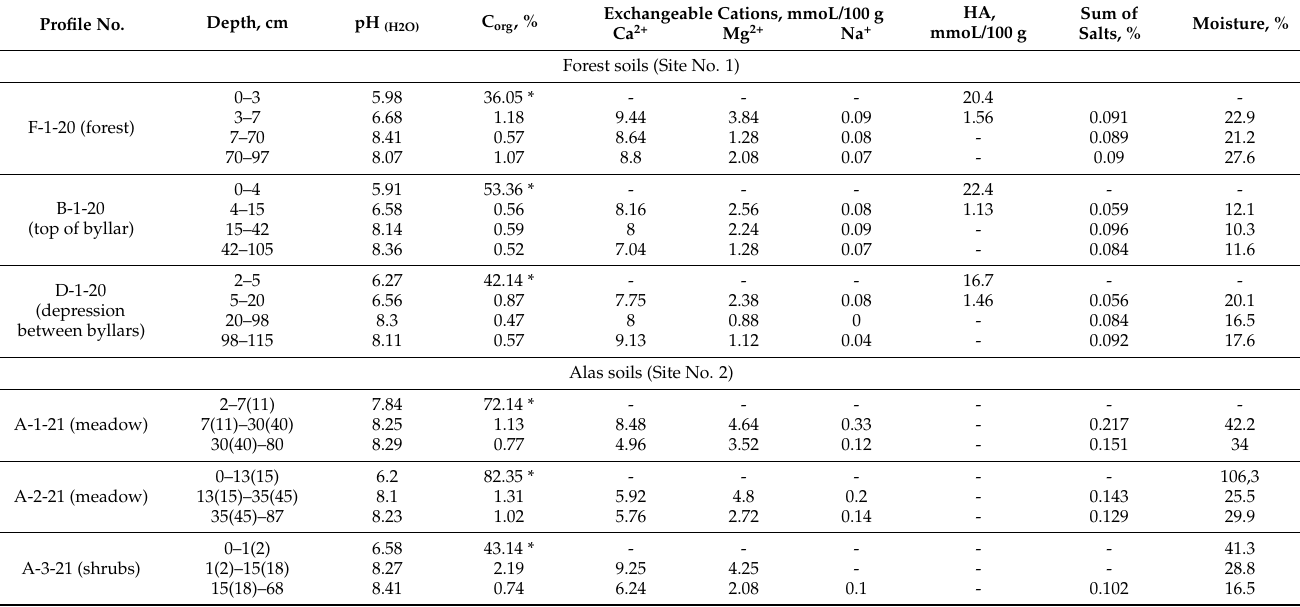
Table 4. Physical and chemical properties of studied